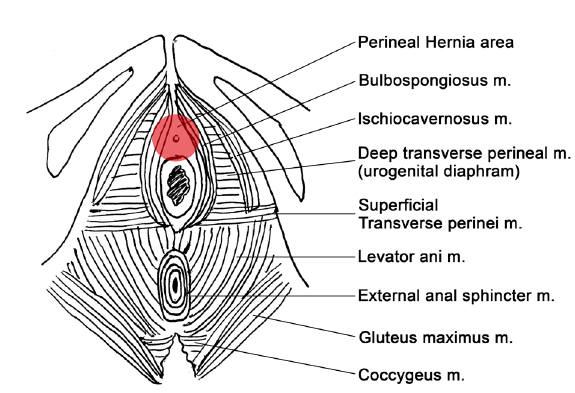
Figure 2 - Anatomy of perineum and location of this anterior perineal